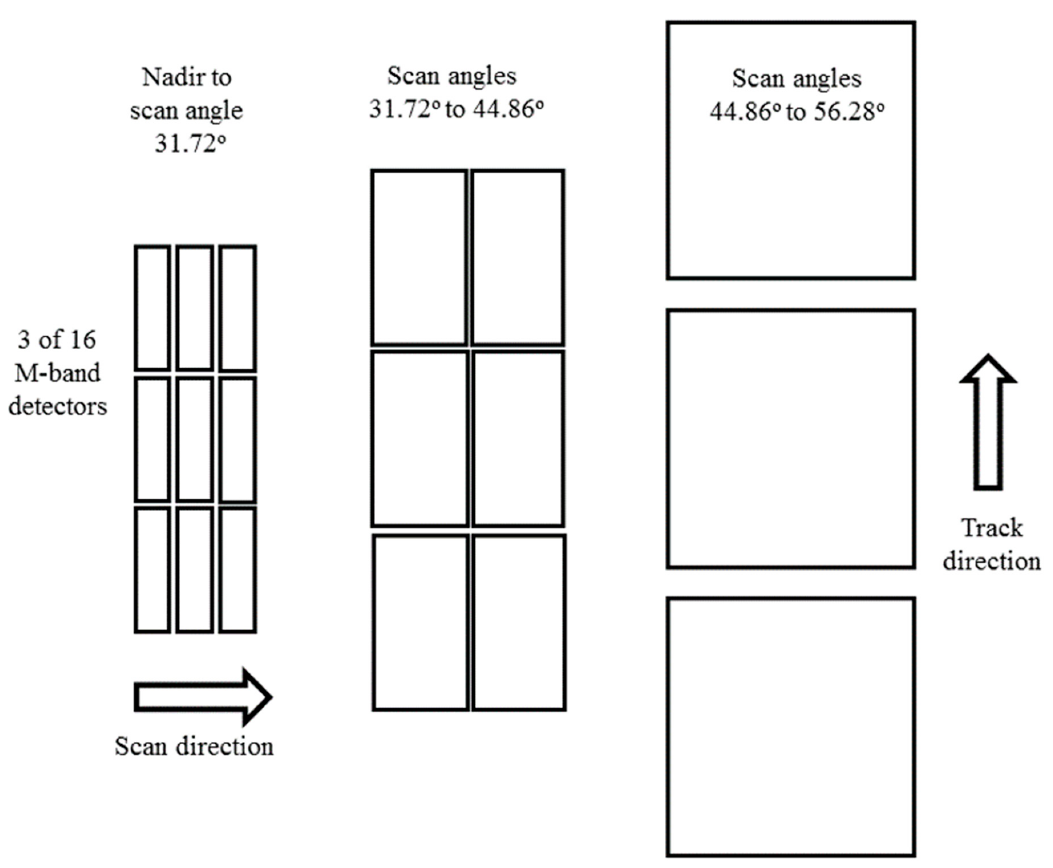
Figure 2. Schematic representation of the growth of the VIIRS M-band pixels across the scan illustrating the beneficial effects of pixel aggregation.